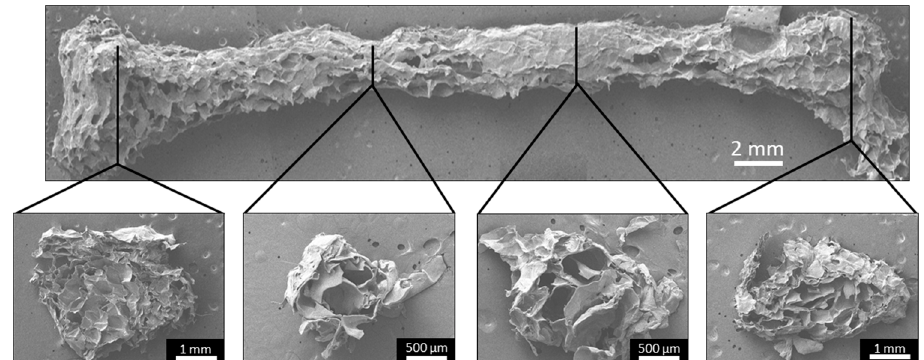
Figure 7. The FF technique creates porosity throughout the printed structure. SEM images of the FF femur display the surface morphology and pore structure. All of the cross-sections had a porous structure, confirming that pore formation occurred throughout the structure.